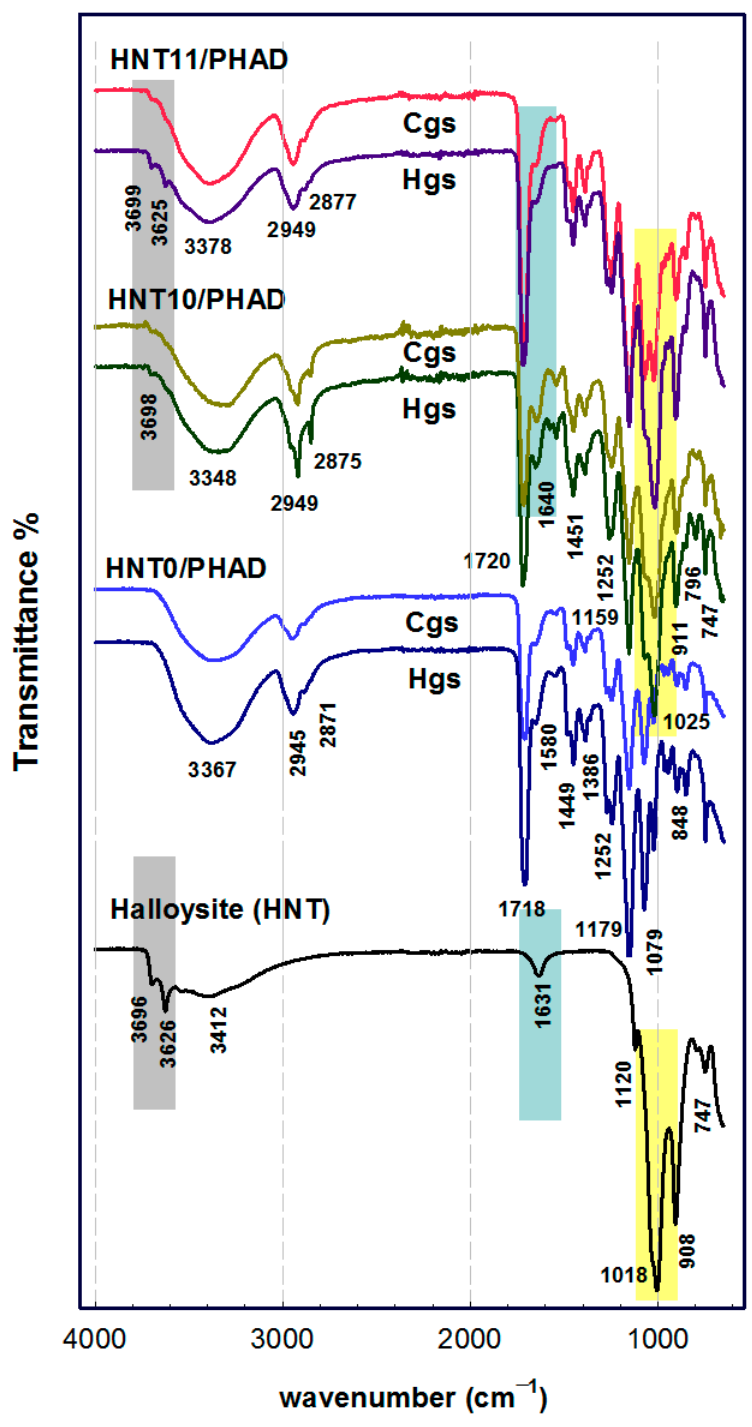
Figure 1. ATR-FTIR spectra of ternary hybrid hydrogel and cryogel, HNT10/PHAD and HNT11/PHAD-Hgs and -Cgs prepared at HNT content 2.80% and 3.20% ( w / v ), HNT-free hydrogel and cryogel (HNT0/PHAD-Hgs and -Cgs), and neat Halloysite nanotube (HNT). The absorption band at 1179 cm − 1 were assigned to the symmetric stretching vibration of C-N band associated with the DEAEMA units, while the contribution of the ester group of DEAEMA was observed as a shoulder at 1182 cm − 1 . The absorption bands at 2871–2877 cm − 1 were the bending vibrations of − CH 2 and − CH groups of the − N(C 2 H 5 ) 2 groups, while the bands at 1580 cm − 1 were observed due to the coordination of the free electron pair of